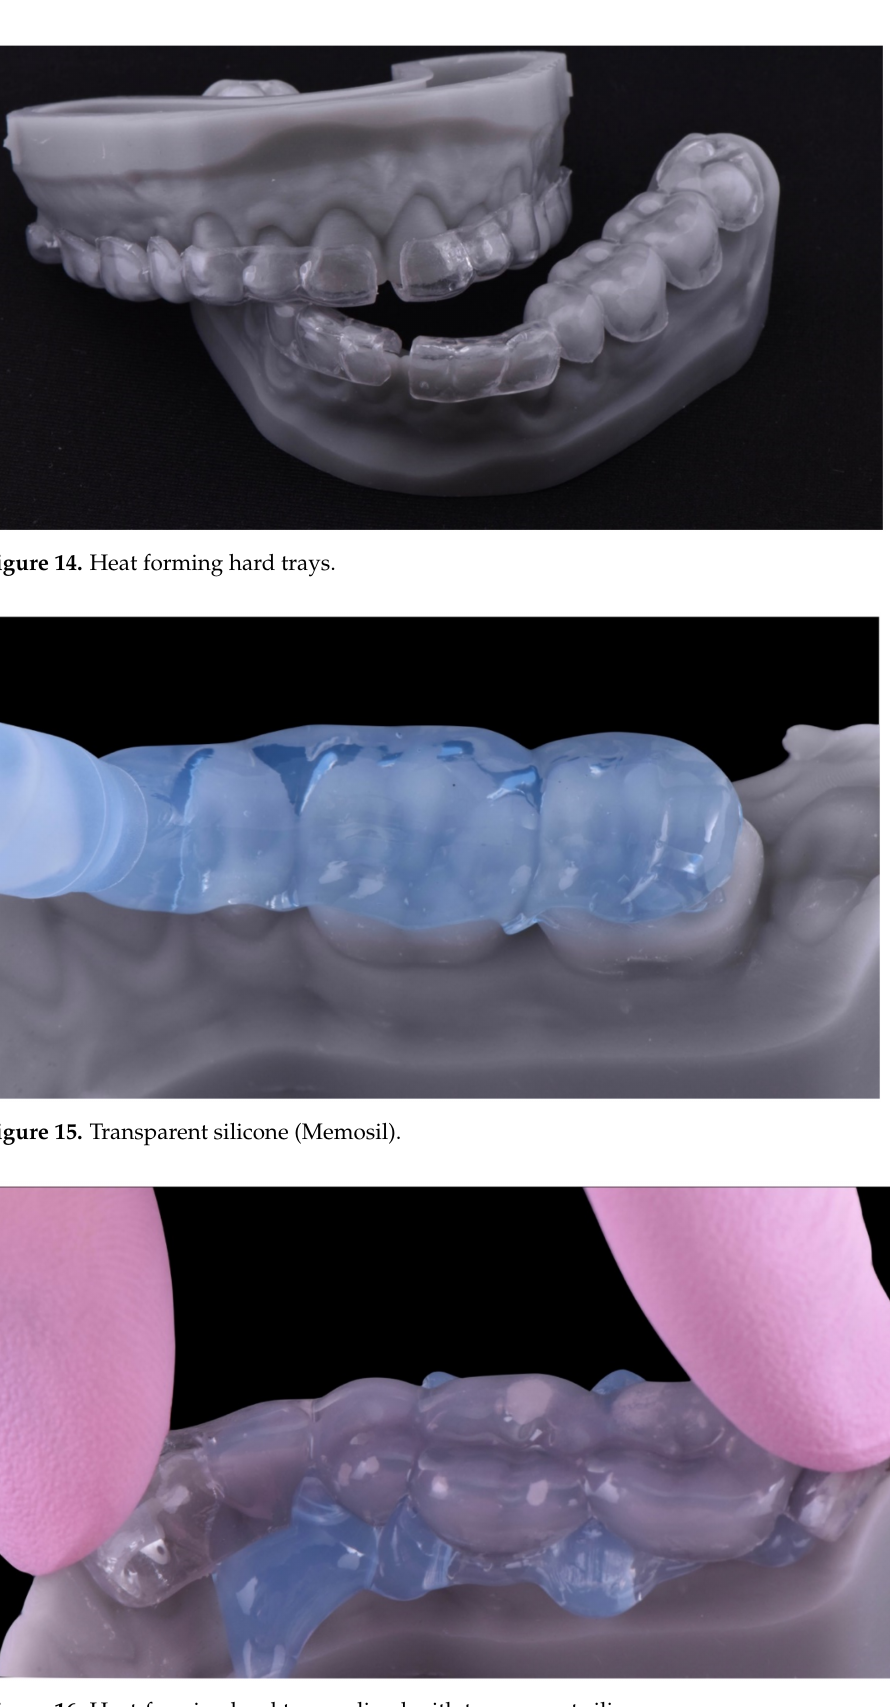
Figure 16. Heat-forming hard trays relined with transparent